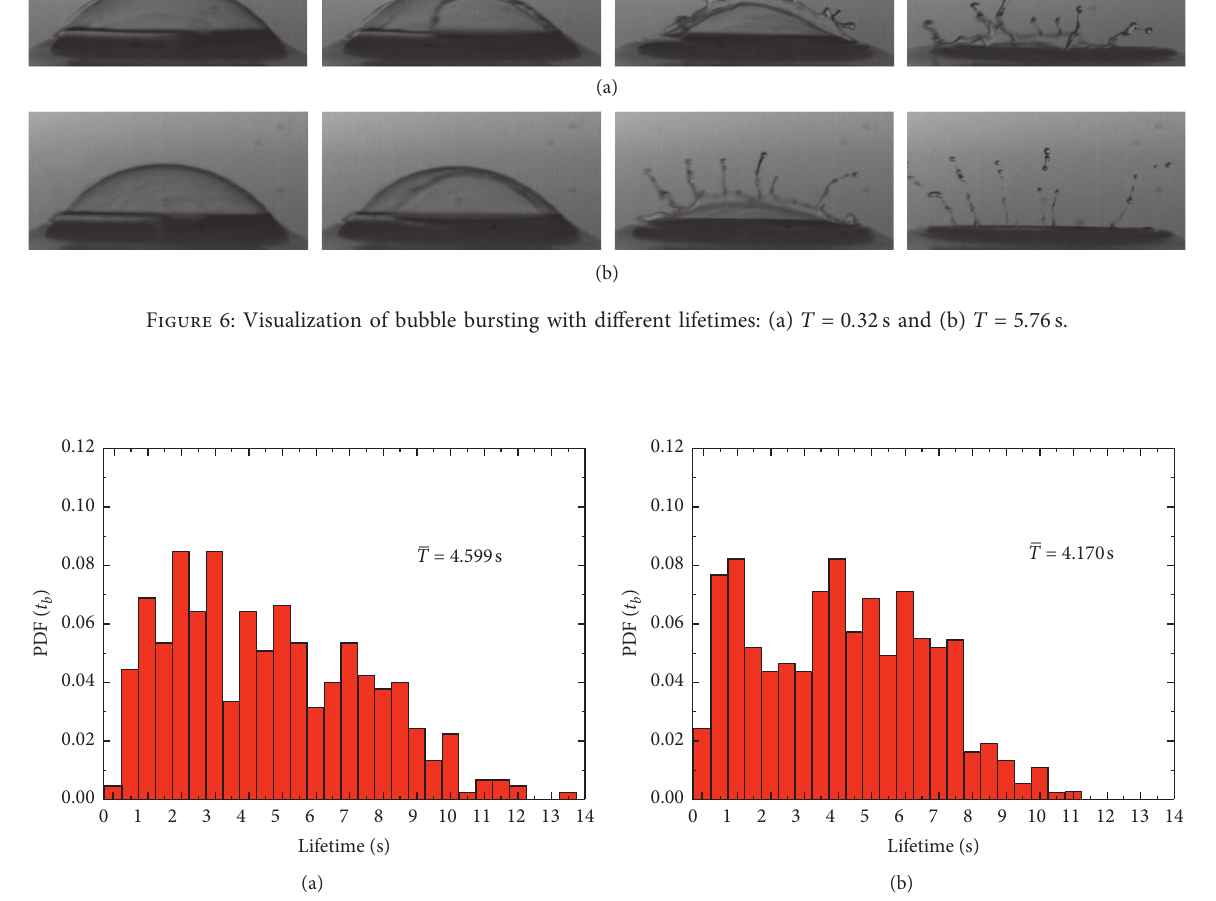
Figure 7: Bubble lifetime distribution histogram at a liquid temperature of 19.0 ° C and an air temperature of 20.0 ° C: (a) cap diameter � 11- 12mm and (b) cap diameter � 12.4–13.6mm.